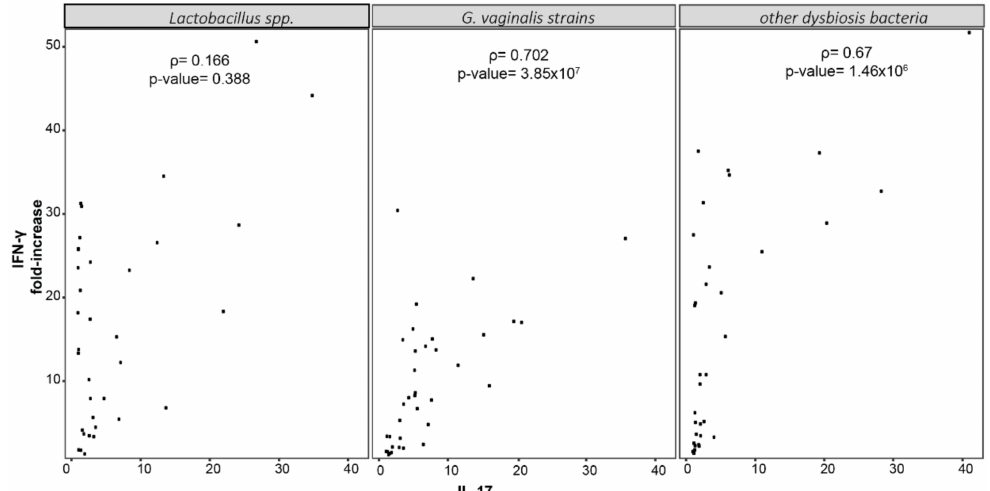
Figure 5. Spearman’s correlation analysis among cytokines produced in cultures with Lactobacillus spp., G. vaginalis strains, other vaginal dysbiosis bacteria. Correlation among cytokines produced under different stimulation was evaluated by Spearman rank correlation